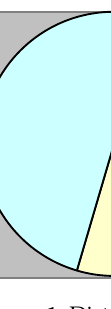
Figure 1. Distribution of coronary diffuseness in the investigated group: 114 patients had 3-vessel disease, 83—2-vessel disease, 48—1-vessel disease and 5 had no significant stenosis in the coronary